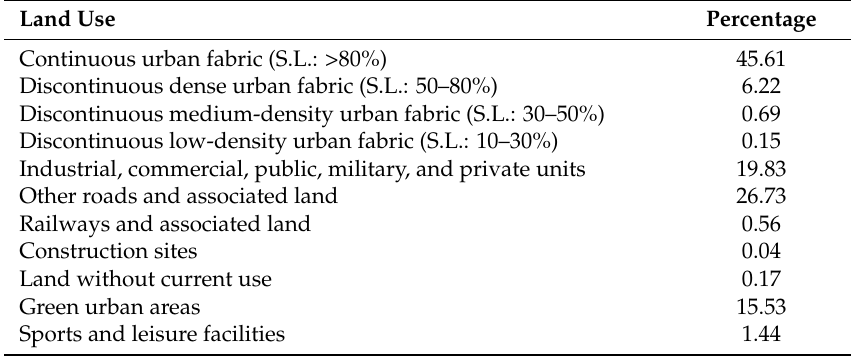
Table 4. Land use percentages for the municipality of Athens based on the Urban Atlas data.